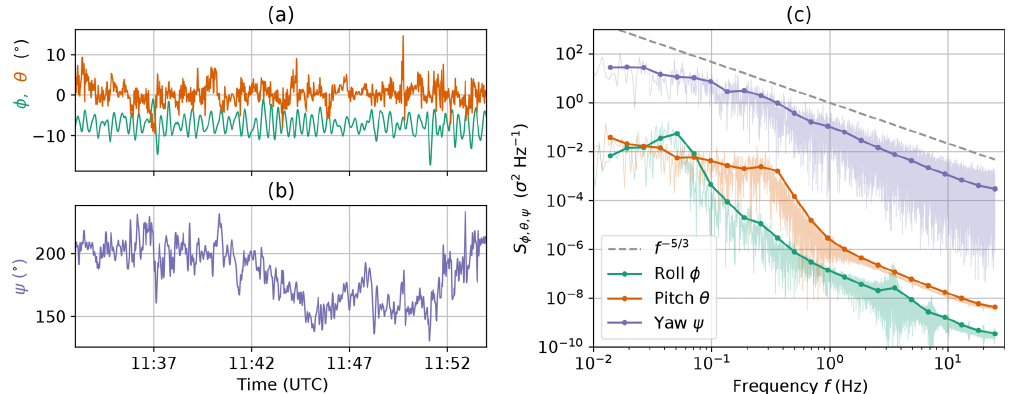
Figure 4. Time series (a, b) and power spectral density S (c) of the Euler angles roll φ , pitch θ and yaw ψ measured by the IMU on the UP. The time series used for the spectra calculations was recorded on 5 June 2017, 11:33–11:54UTC, with the balloon kept at 20m altitude.